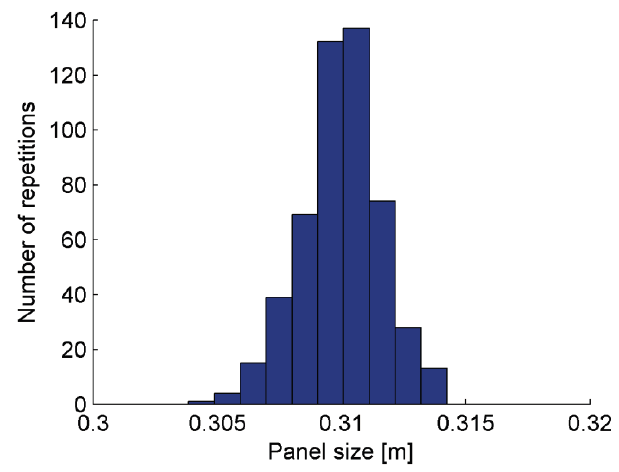
Figure 13. Collection of samples returned by the analysis of the board